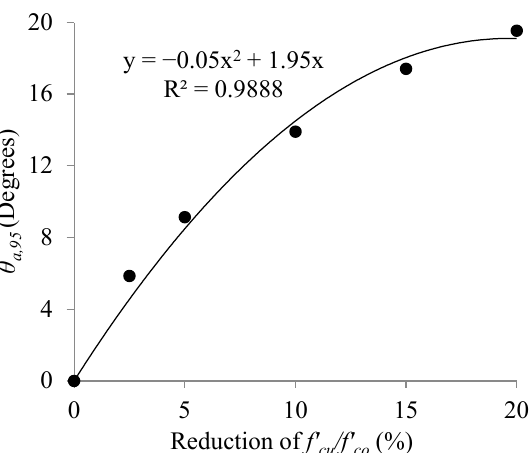
Figure 8. Variations of θ a ,95 with respect to reductions in f (cid:48) cu / f (cid:48) co .